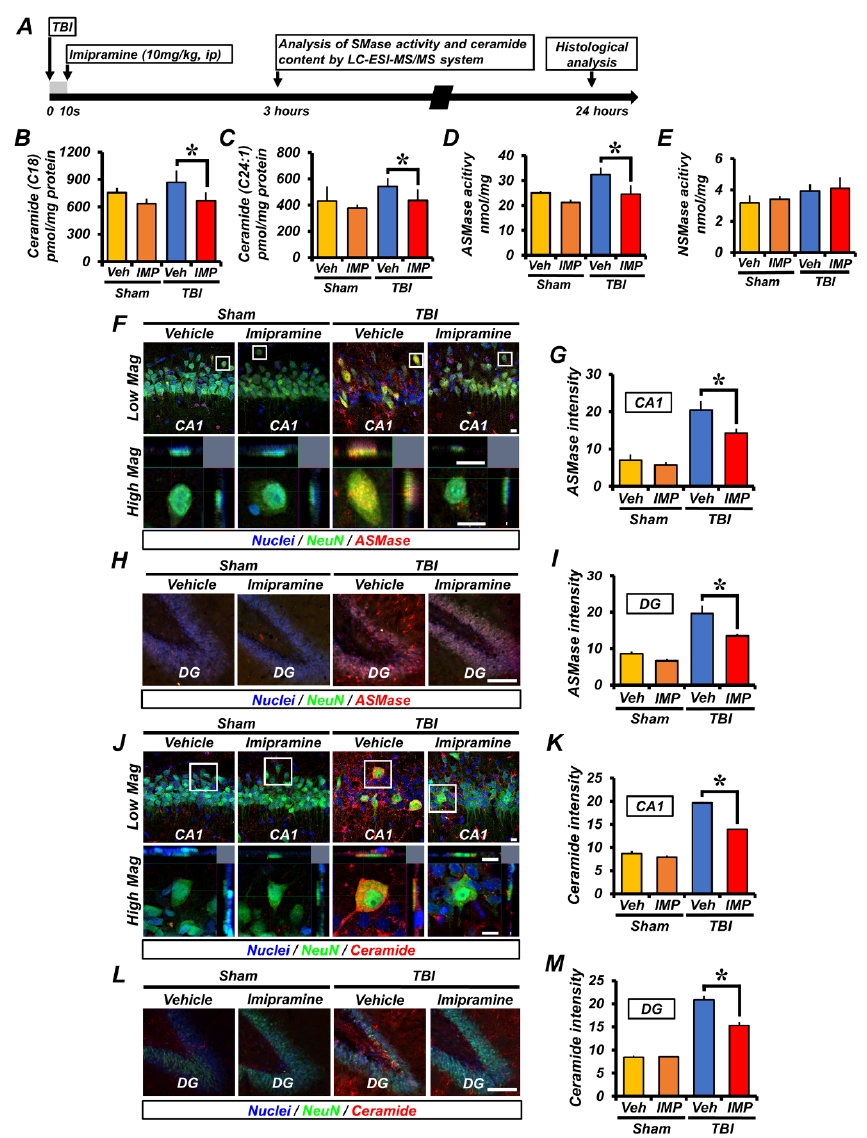
Figure 1. Imipramine treatment reduced ASMase and ceramide activity after TBI. ( A ) Experimental procedures are demonstrated by timeline. Imipramine was injected immediately after TBI impact. Next, ASMase and ceramide analyses were performed 3 h after TBI. Histological analysis was per- formed 24 h after TBI. ( B , C ) Quantification of ceramide (C18 and C24:1) activity. ( D , E ) Quantification of ASMase and NSMase. Data are mean ± SEM; n = 3 from each sham group, n = 7 from TBI-vehicle group, and n = 8 from TBI-imipramine group. ( F , H ) Fluorescent images show effect of imipramine on ASMase activity. ASMase (red) intensity shown for hippocampal CA1 and DG in sham-operated, TBI-vehicle, and TBI-imipramine groups. Scale bar = 10 and 100 µ m, respectively. ( G , I ) Quantification of ASMase fluorescence intensity on hippocampal CA1 and DG. Data are mean ± SEM; n = 4 from each sham group; n = 6 from each TBI group. * p < 0.05 vs. the vehicle-treated TBI group. ( J , L ) Fluorescent images show effect of imipramine on ceramide activity. Ceramide (red) intensity shown on hippocampal CA1 and DG in sham-operated, TBI-vehicle, and TBI-imipramine treated groups. Scale bar = 10 and 100 µ m, respectively. ( K , M ) Quantification of ceramide fluorescence intensity on hippocampal CA1 and DG. Data are mean ± SEM; n = 4 from each sham group; n = 6 from each TBI group. * p < 0.05 vs. vehicle-treated TBI